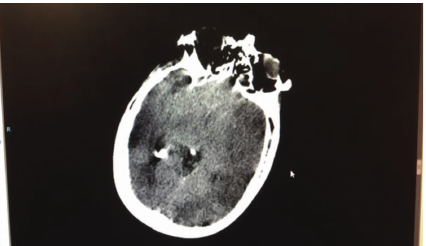
Figure 1: Head computed tomography image without contrast, showing left middle cerebral artery territory infarction.